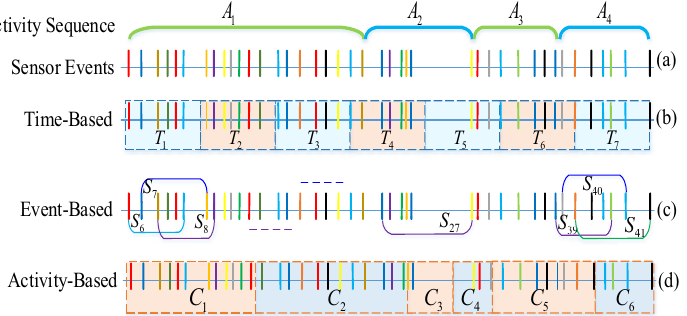
Figure 2. Different segmentation methods on streaming data. ( a ) Ground truth of a sequence of activities. ( b ) Time-based windowing. ( c ) Sensor event-based windowing. ( d ) Activity-based